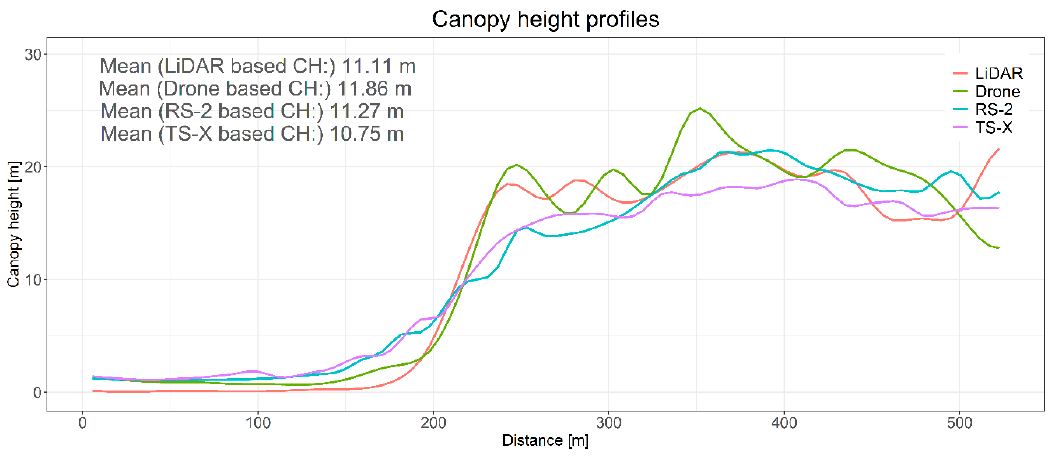
Figure 4. Example height profile of reference LiDAR canopy height, drone canopy height, modelled RS-2 canopy height based on the interferogram from 03.09.-27.09 and modelled canopy height based on TS-X from 06.09.-17.09.